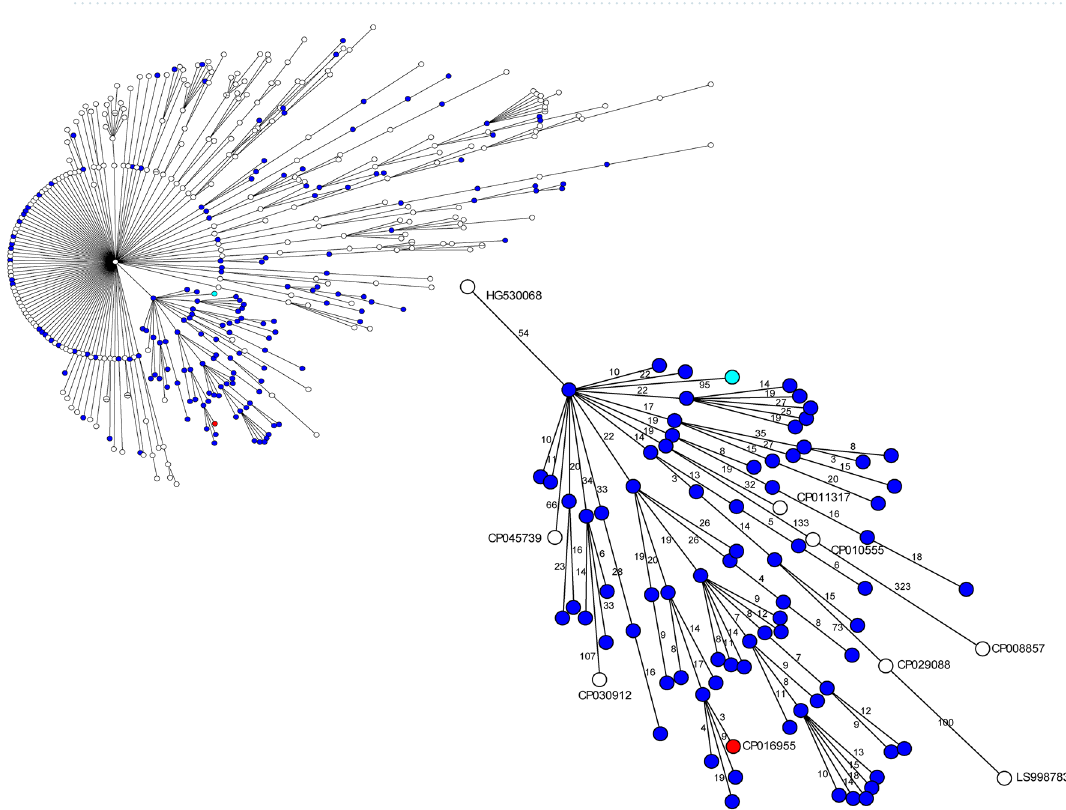
Figure 4. Minimum-spanning tree of the 168 P. aeruginosa isolates sequenced in this study (blue circles), and of 260 P. aeruginosa chromosomal sequences obtained from the NCBI GenBank database (white circles) based on wgMLST analysis. The enlarged portion of the tree displays Group 1 isolates, and the closely-related NCBI sequences with their accession numbers. The teal circle denotes the CIM-negative ST111/O12 isolate from this study that partitioned the closest to Group 1. The red circle indicates the Erasmus MC reference isolate that was used to design the wgMLST scheme. For understanding distances between isolates, refer to Fig.